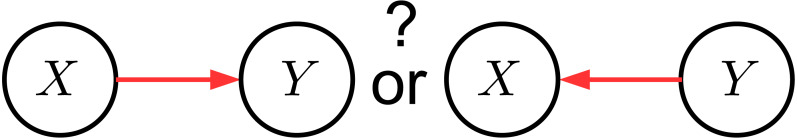
An illustration of the goal of our proposed method.It aims to identify the causal DAG of two variables, where either X causes Y or Y causes X.